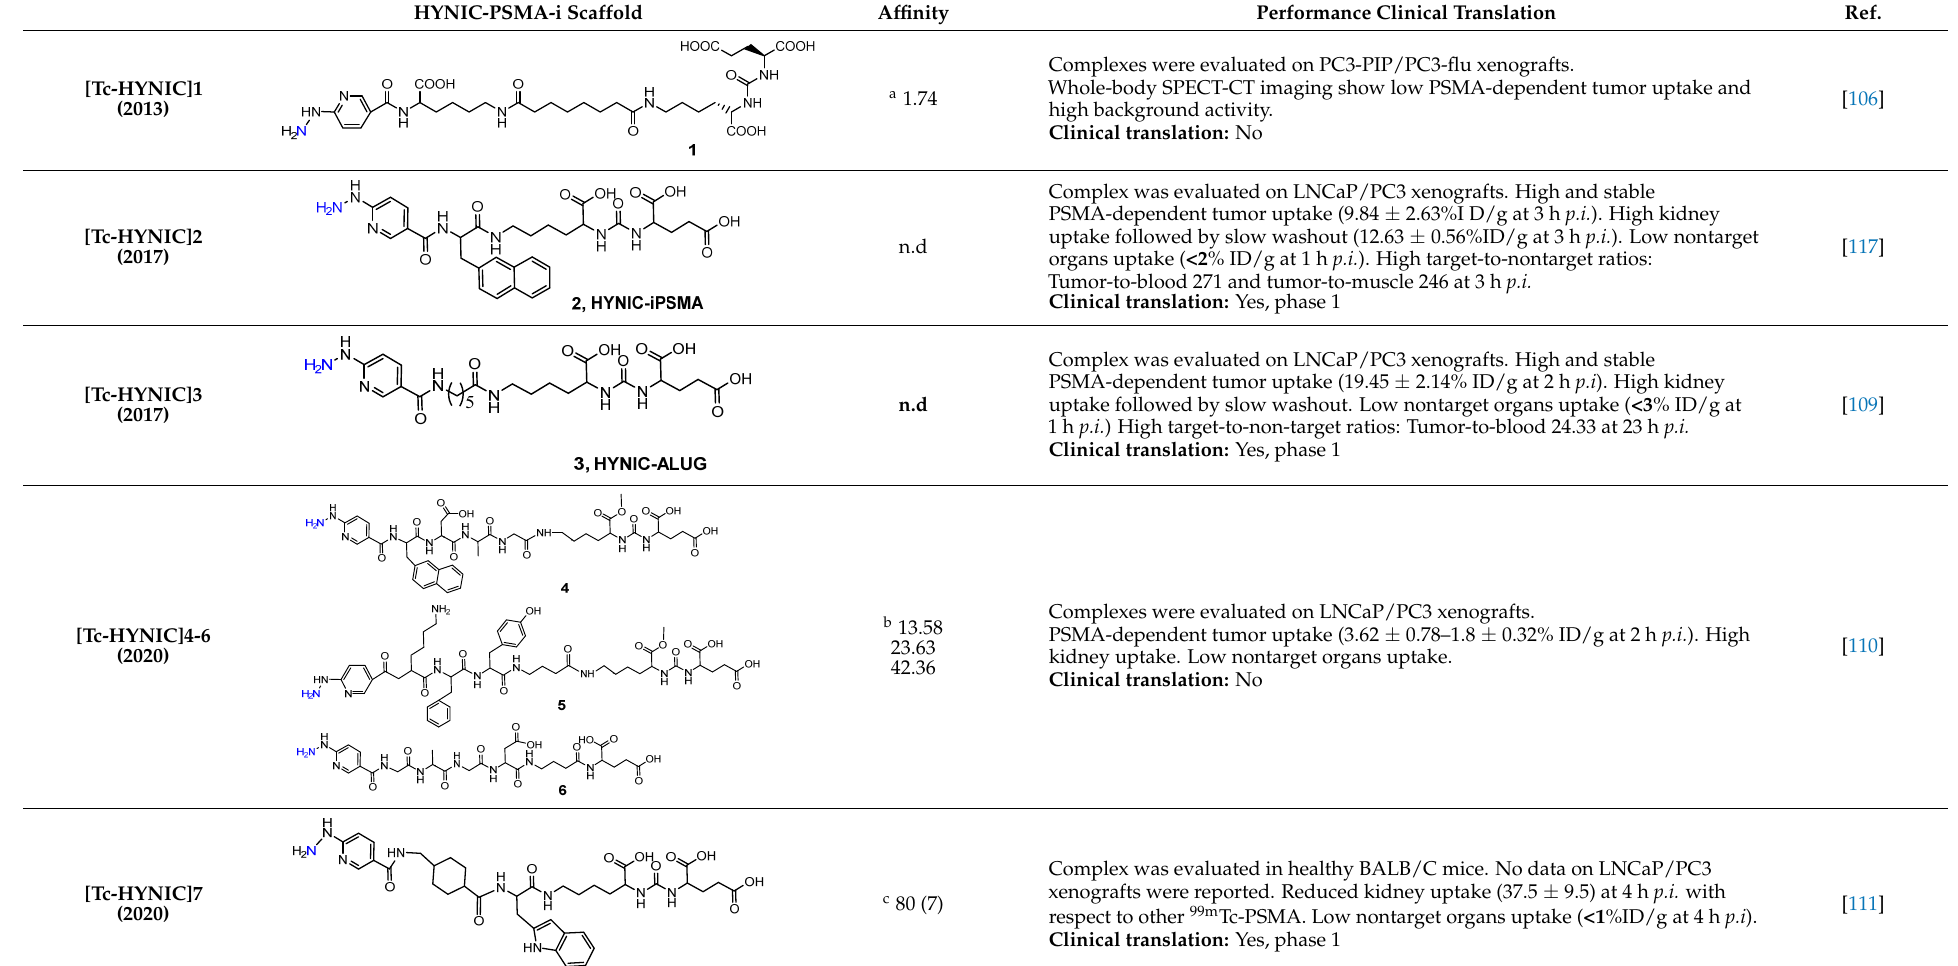
LNCaP/PC3 xenografts were reported. Reduced kidney uptake (37.5 ± 9.5) at 4 h p.i. with respect to other 99m Tc-PSMA. Low (37.5 ± 9.5) at 4 h p.i. with respect to other 99m Tc-PSMA. Low nontarget organs uptake ( <1 %ID/g at 4 h p.i ). nontarget organs uptake ( <1 %ID/g at 4 h p.i